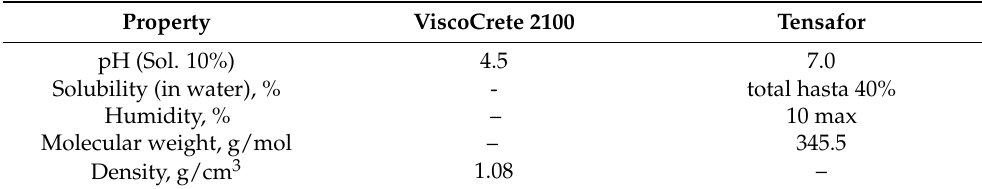
Table 1. Plasticizers’